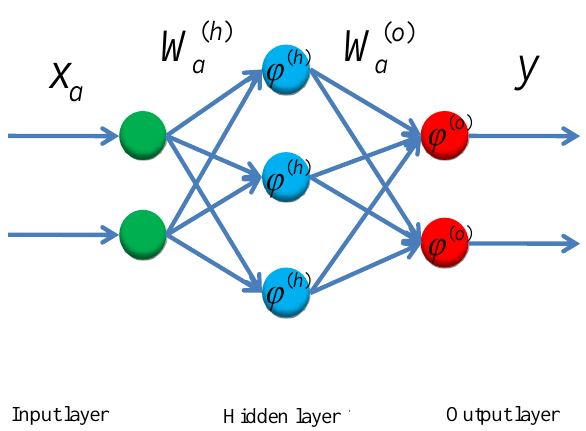
Figure 7. An example of a MFNN.